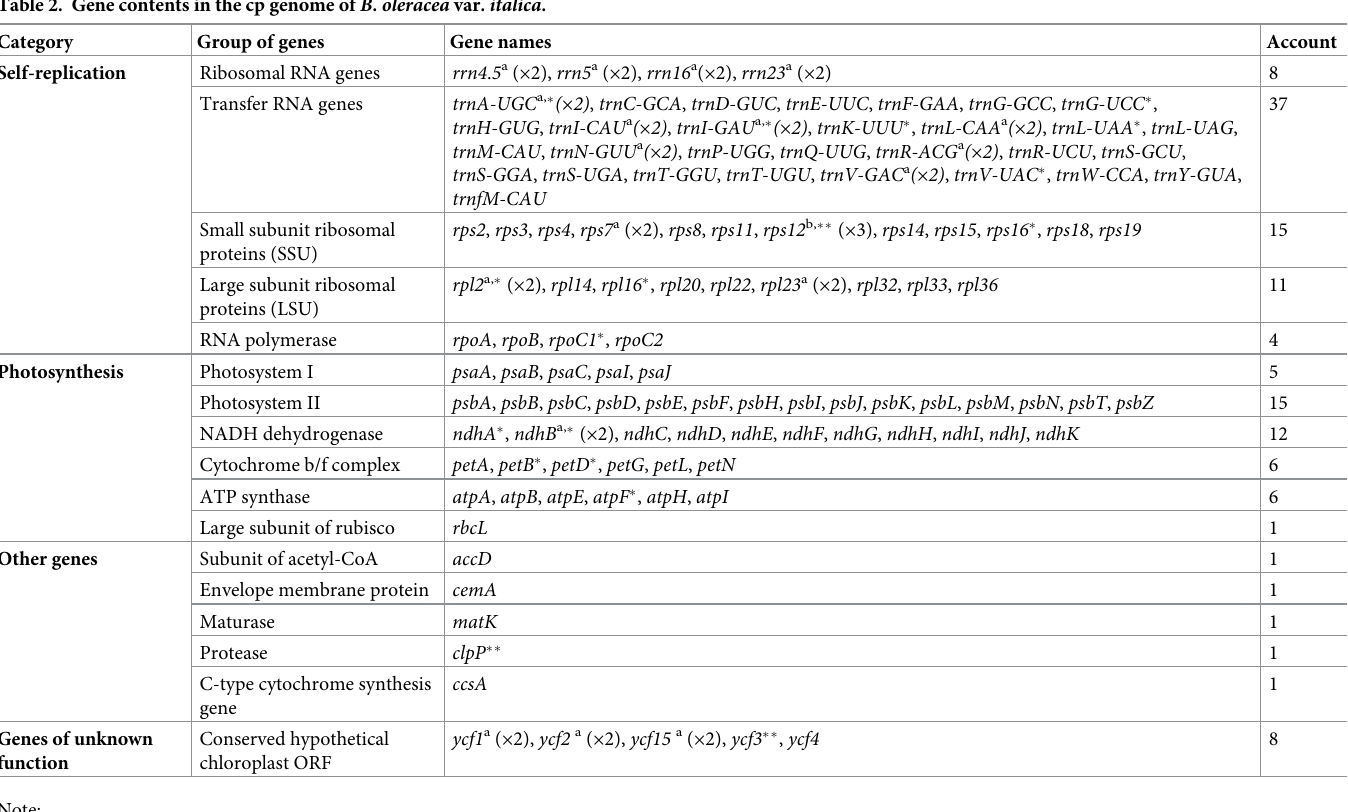
Table 2. Gene contents in the cp genome of B . oleracea var. italica .